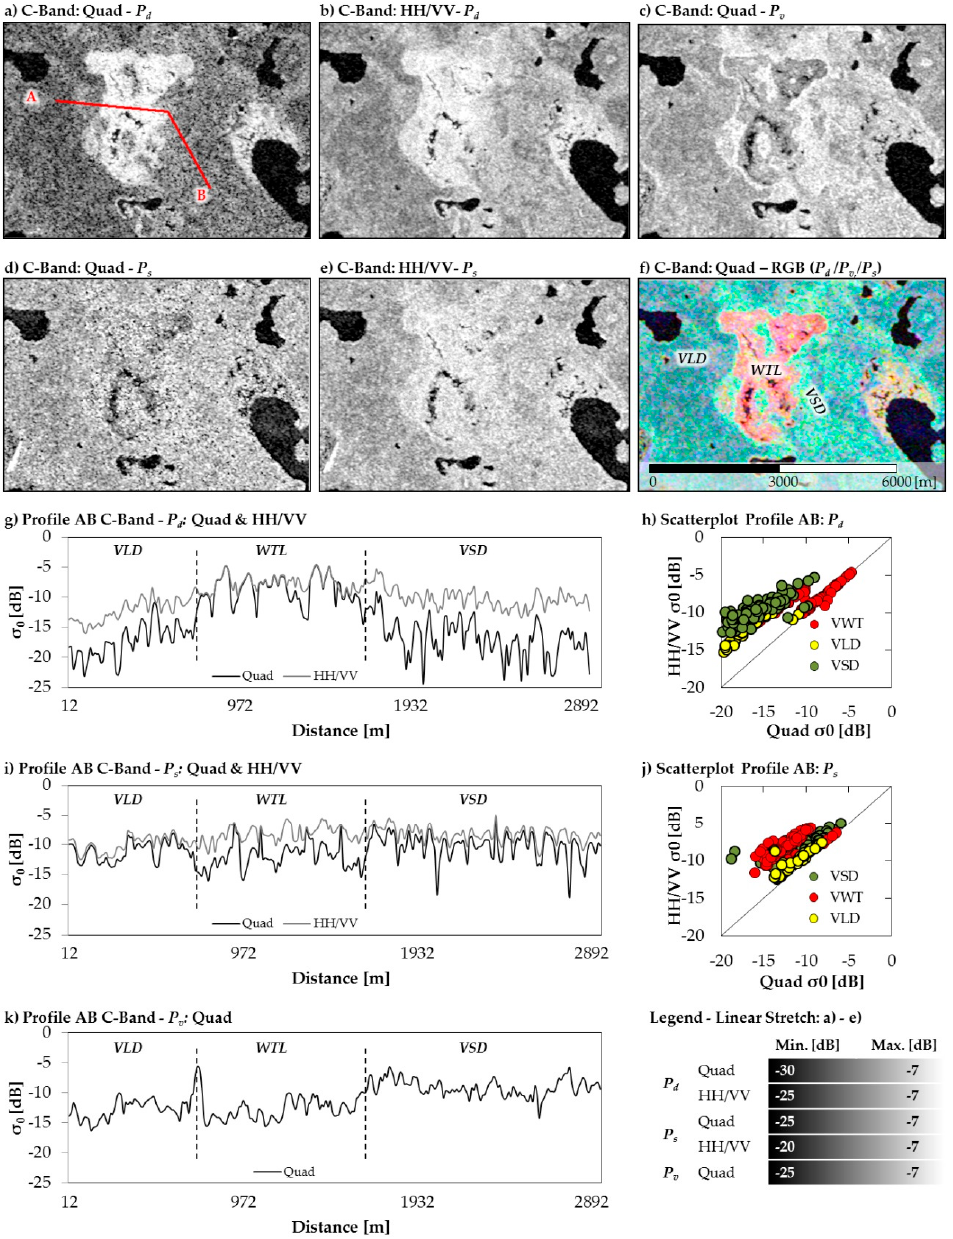
Figure 7. Profile analysis of C-Band Radarsat-2 data of the test site Tuktoyaktuk (TUK): ( a – e ) images of the two and three component decomposition features double bounce (P d ), surface scattering (P s ) and volume scattering (P v ); ( f ) RGB colour composite of three component decomposition; ( g ) profile values of P d (two and three component decomposition); ( h ) scatterplot of P d of two and three component decomposition; ( i ) profile values of P s (two and three component decomposition); ( j ) scatterplot of P s of two and three component decomposition and ( k ) profile values of P v of the three component decomposition. The abbreviations “VLD”, “VWT”, and “VSD” refer to the dominating land cover units: low/sparse vegetated tundra, wetland and shrub dominated tundra. The differences between both datasets are bigger for the low tundra (VLD) and maximized for the shrub dominated tundra (VSD). Figure 7h shows the scatterplot of two and three component P d